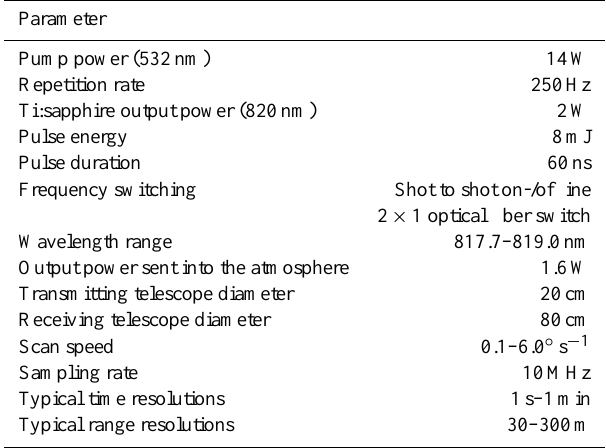
Table 1. Instrument specifications of the UHOH DIAL for scanning WV